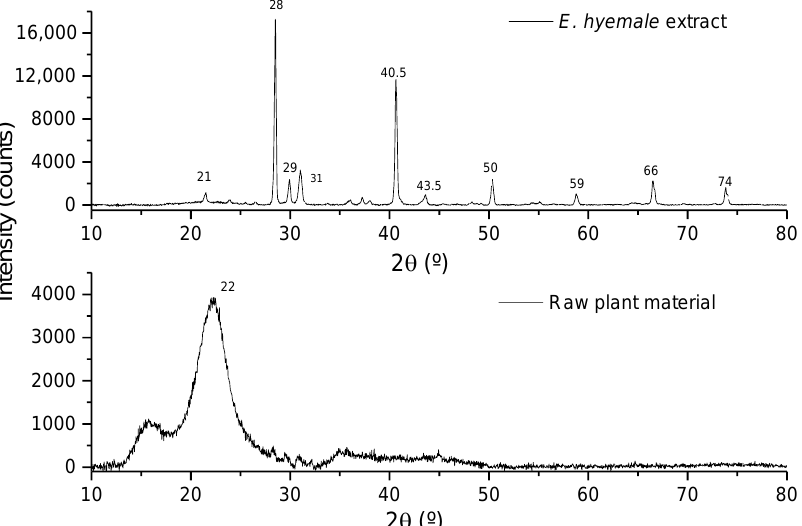
ment of electrons from π orbitals (aromatic forms) to different molecular orbitals of char-